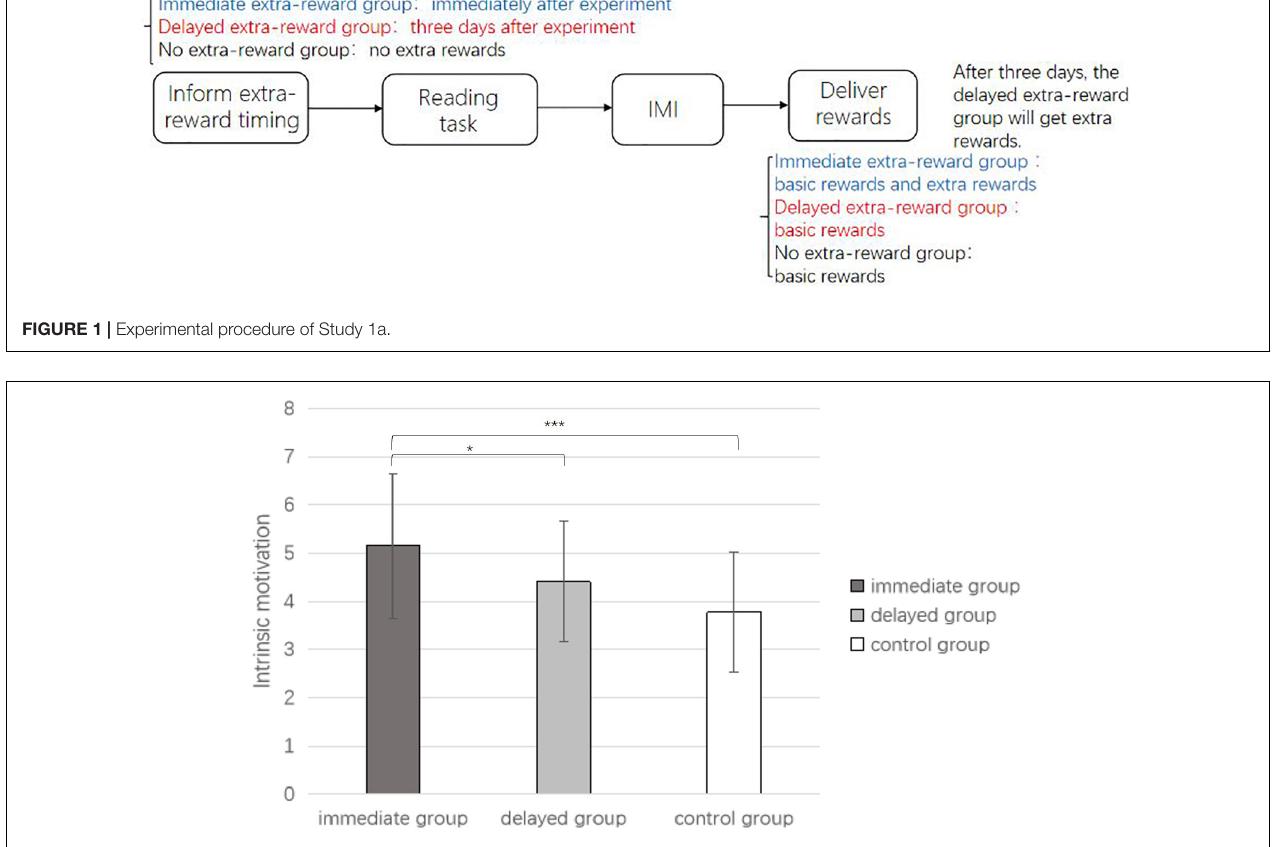
FIGURE 2 | IMI scores under the conditions of immediate extra reward, delayed extra reward, and no extra reward (In the bar graph above, the error bars represent the standard deviations; ∗ represents p < 0.05, ∗∗∗ represents p <